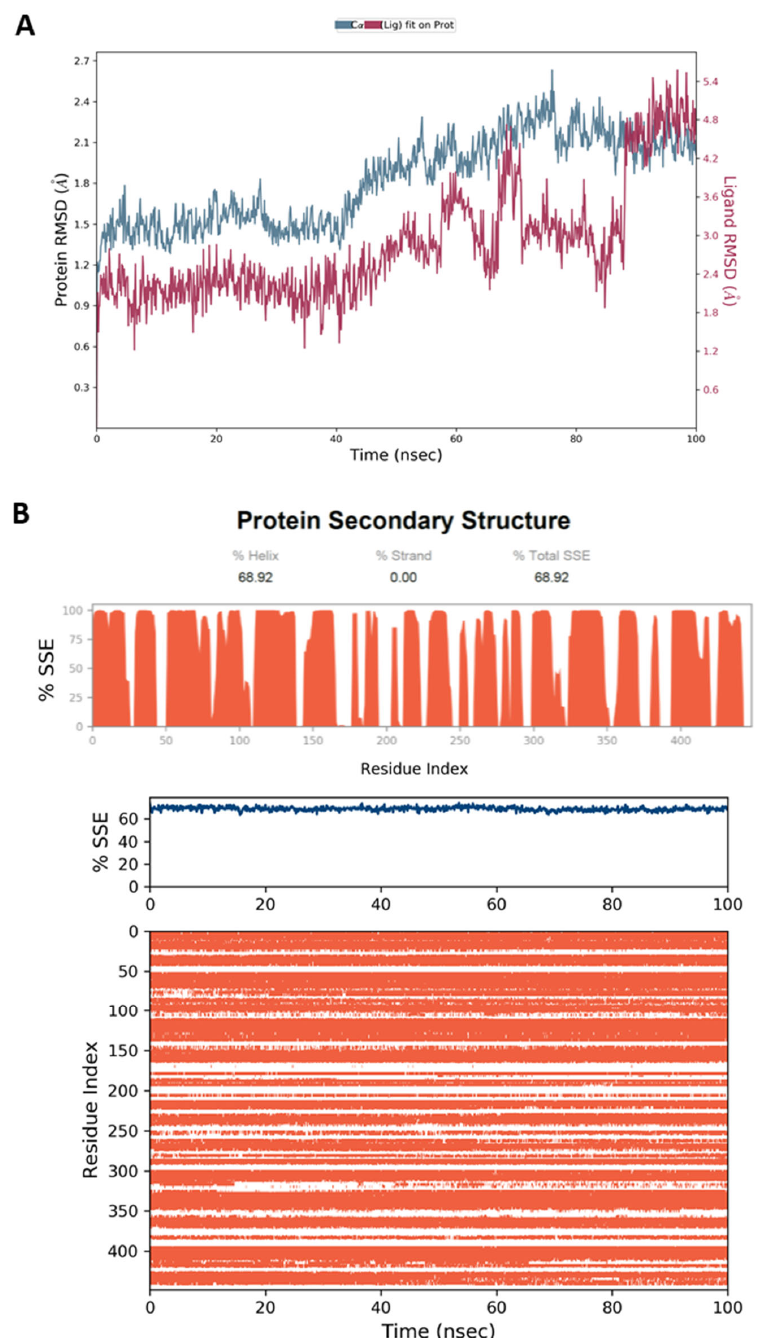
Figure 20. ( A ) RMSD graph for compound 64 when complexed with the GLUT1 protein (PDB ID: 5EQG). The simulation time (100 ns) confirmed the stability of the complex, with no significant changes in the protein structure. ( B ) Stability of the secondary structure of the GLUT1 protein (PDB ID: 5EQG) throughout the MD simulation when complexed with 64 . The protein secondary structure elements (SSE) were monitored during the simulation. The upper plot presents SSE distribution by residue index across the protein structure. The middle plot summarizes the SSE composition for each trajectory frame throughout the simulation, and the plot at the bottom monitors each residue and its SSE assignment over the simulation time.